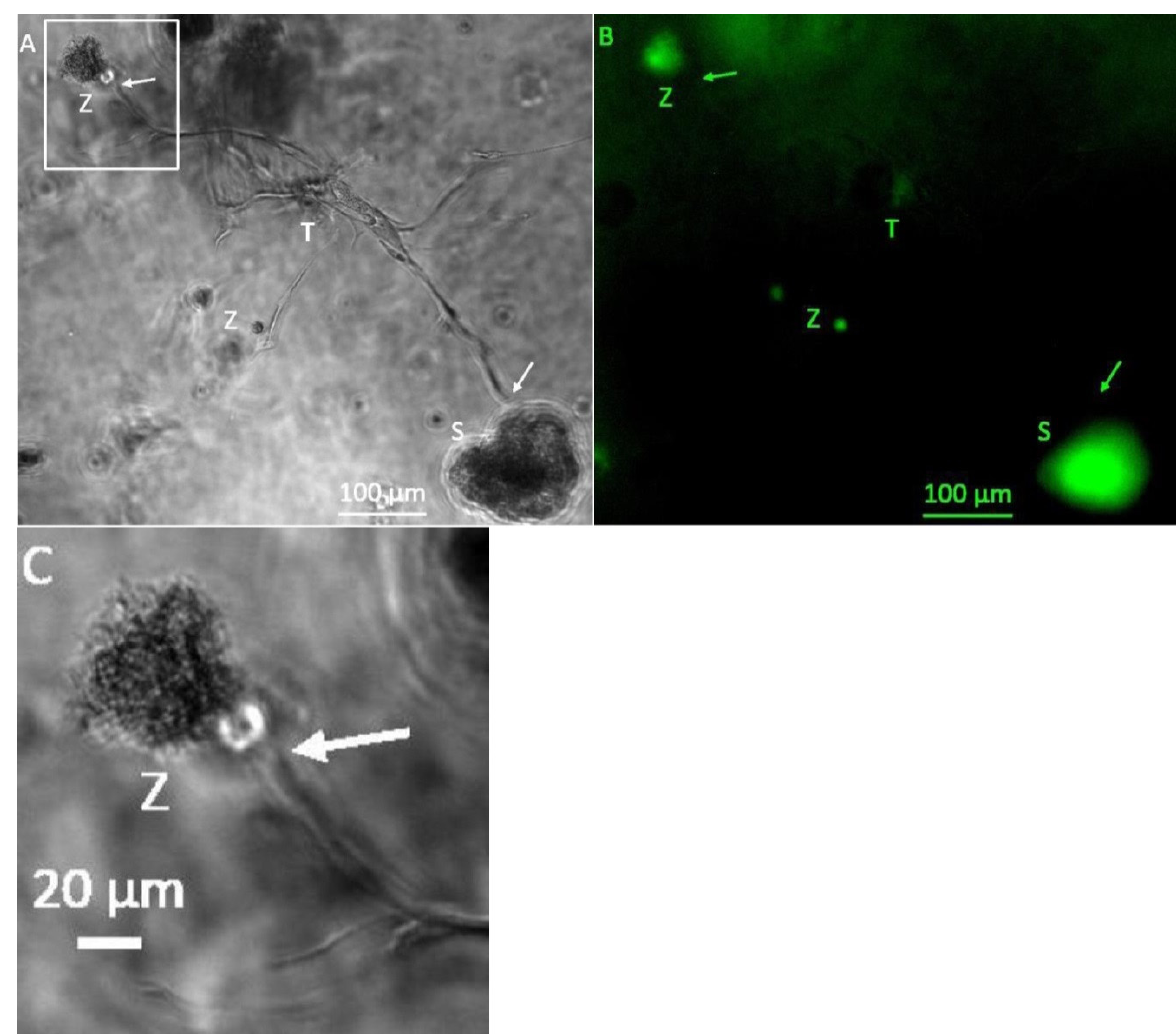
Figure 2. Representative photomicrographs of a 3D hydrogel tumor-stroma culture on day 13 ( A ): central tubular structure (T), individual cells and cell clusters (Z) and a tumor cell spheroid (S). Bifurcation of the tubular structure and growth into the direction of the H838 tumor spheroid, or the cell accumulation in the upper left corner of the picture (arrows). The spheroid shows a roundish shape, which appears slightly dented below the bifurcations extending towards it. ( B ): GFP fluorescent image of ( A ). The individual cells and cell accumulation (Z) and the spheroid are GFP-positive. ( C ): Magnified section of ( A ), marked in ( A ).